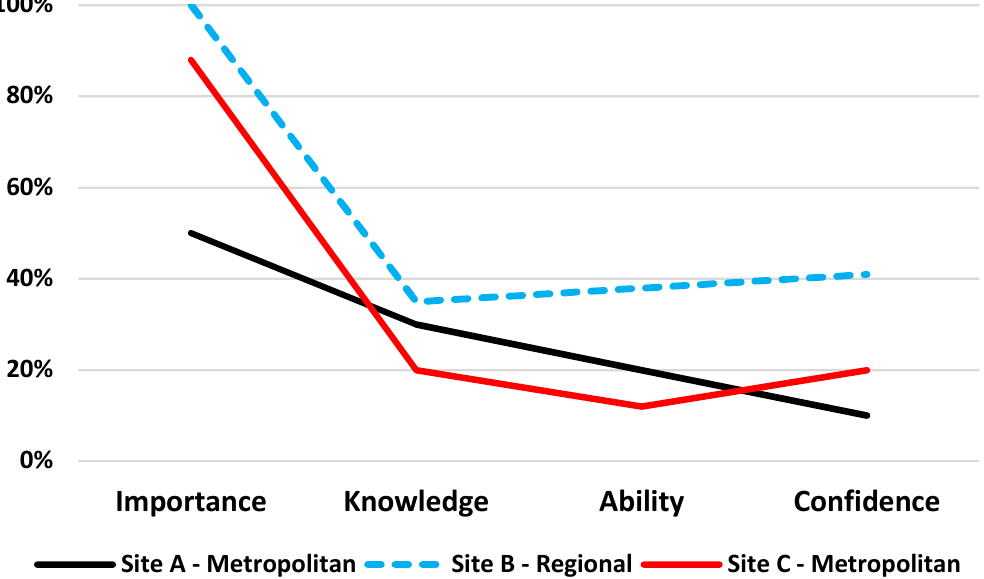
Figure 1. Proportion of clinicians who rated ‘ high ’ the importance, knowledge, ability and confidence to communicate with Indigenous Australian patients.